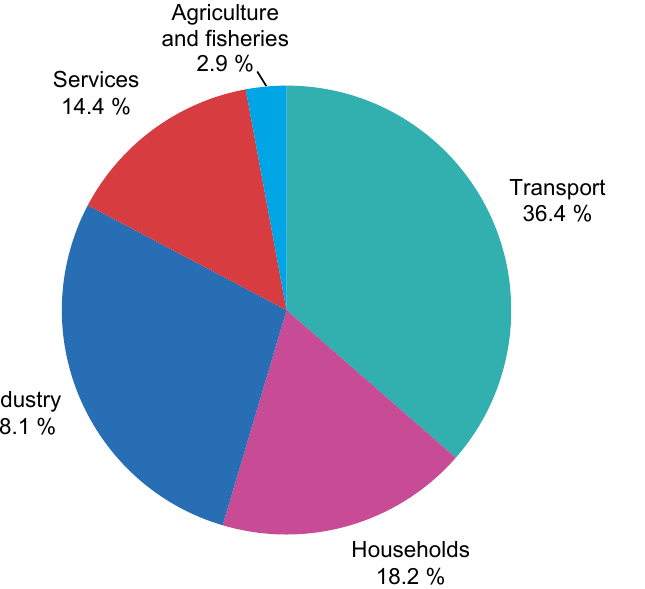
Figure 5. Final energy consumption by sector in Portugal in 2019, expressed as a percentage of the total and based on tons of oil equivalent. The authors created this figure using data from PORDATA [20].